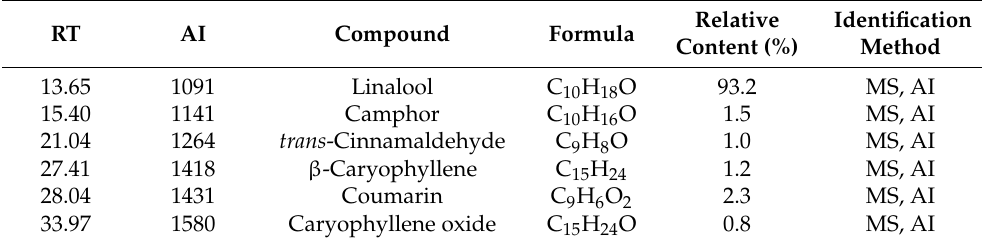
Table 2. Effect of different doses of C. osmophloeum ct. linalool leaf oil on the body weight gain of ICR mice after 6 weeks of oral